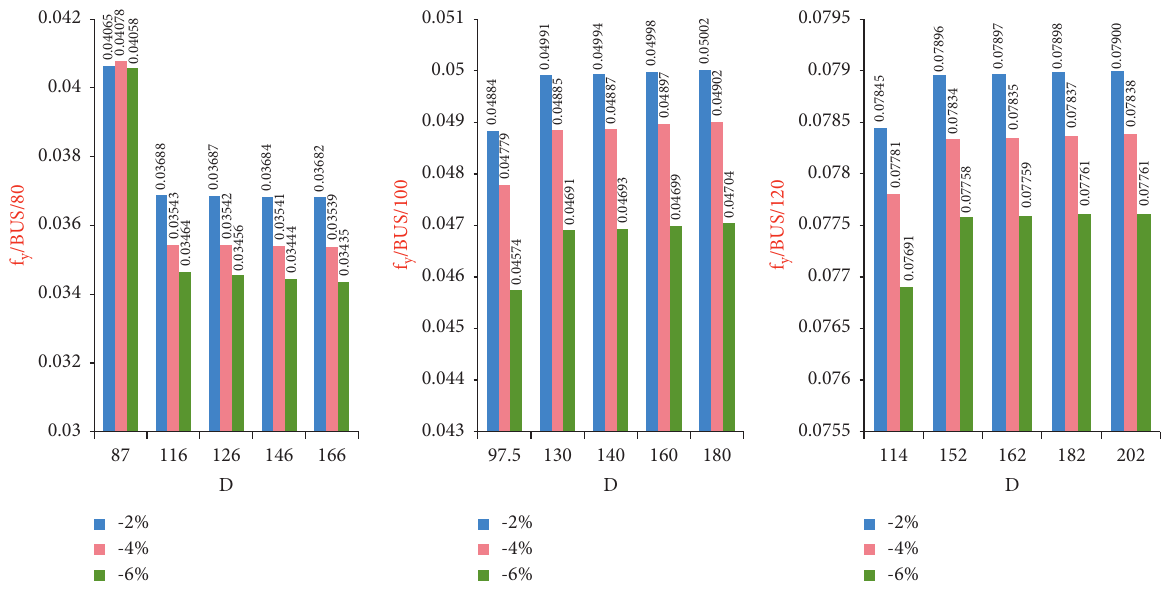
Figure 6: Lateral friction coefficient changes with direct distance changes in the downgrade scenario and speeds of 80, 100, and 120